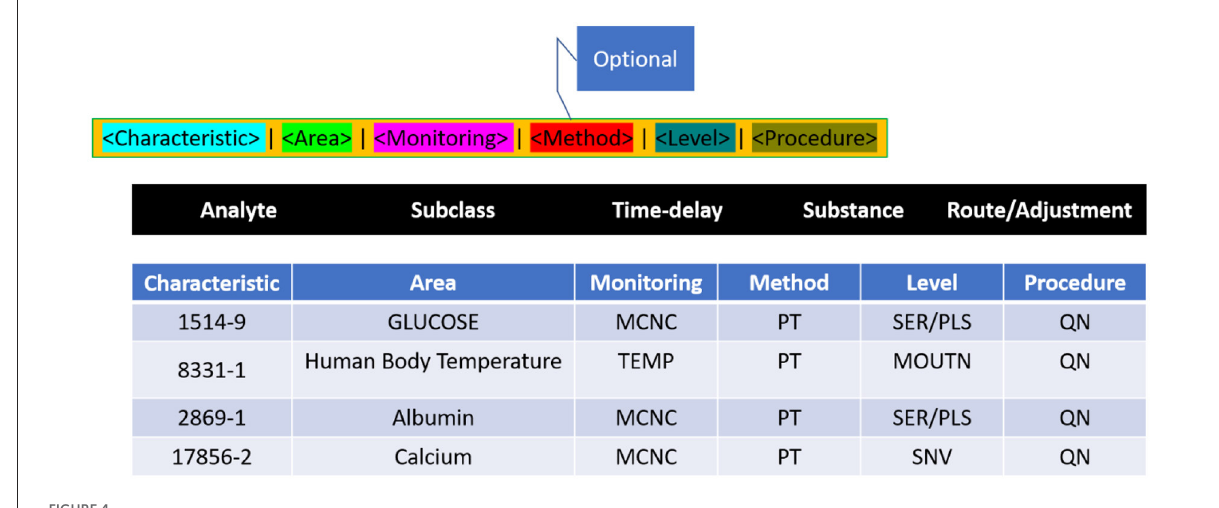
FIGURE4 LONIC nomenclature.